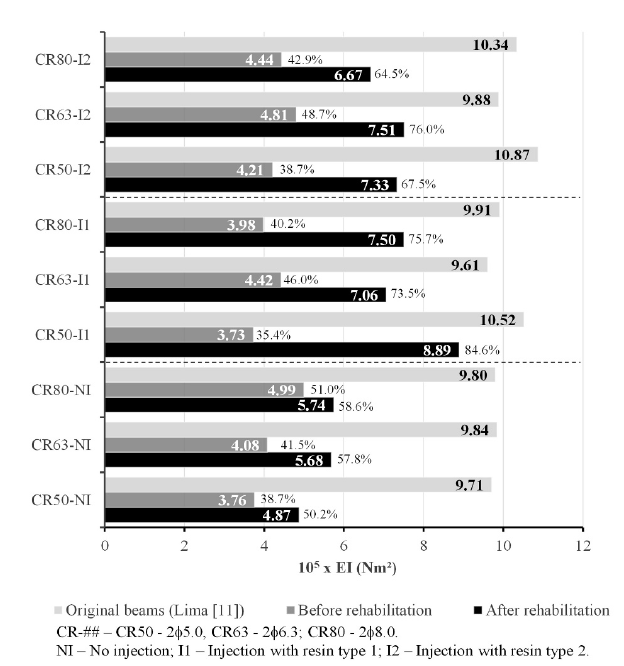
Figure 12. Estimated stiffness of the